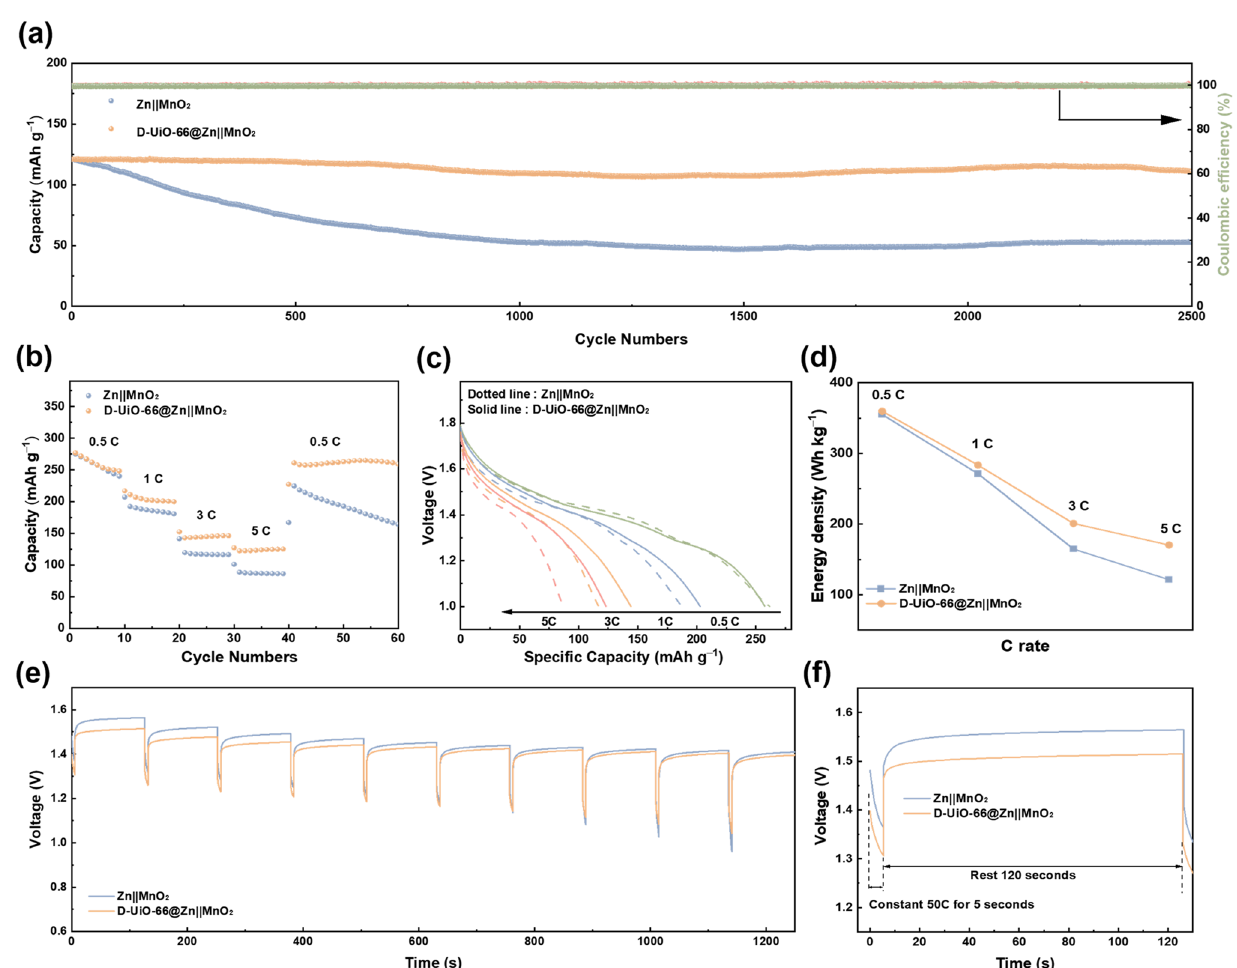
Fig. 5 Performances of Zn||MnO 2 full cells. a Long-cycling performance, b rate performance and c corresponding discharge profiles of Zn||MnO 2 full cells with and without D-UiO-66-based quasi-solid interphase. d Energy output at different C-rate. e voltage–time profiles of the pulse discharge test at a C-rate of 50 and f the magnified view at the first 120